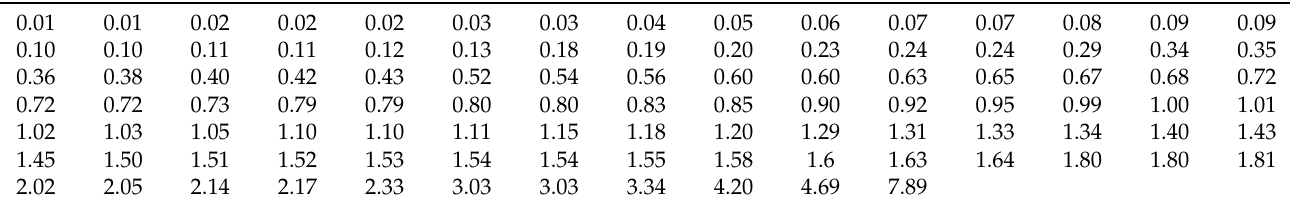
Table 4. Data set of kevlar